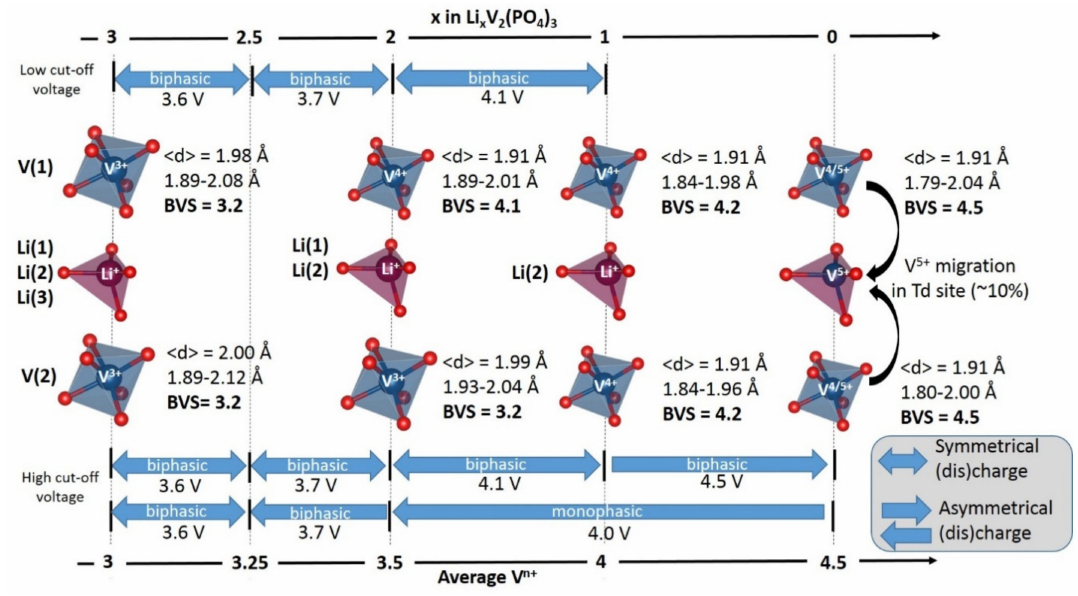
Figure 5. Structural evolution during Lithium extraction/insertion from/into Li 3 V 2 (PO 4 ) 3